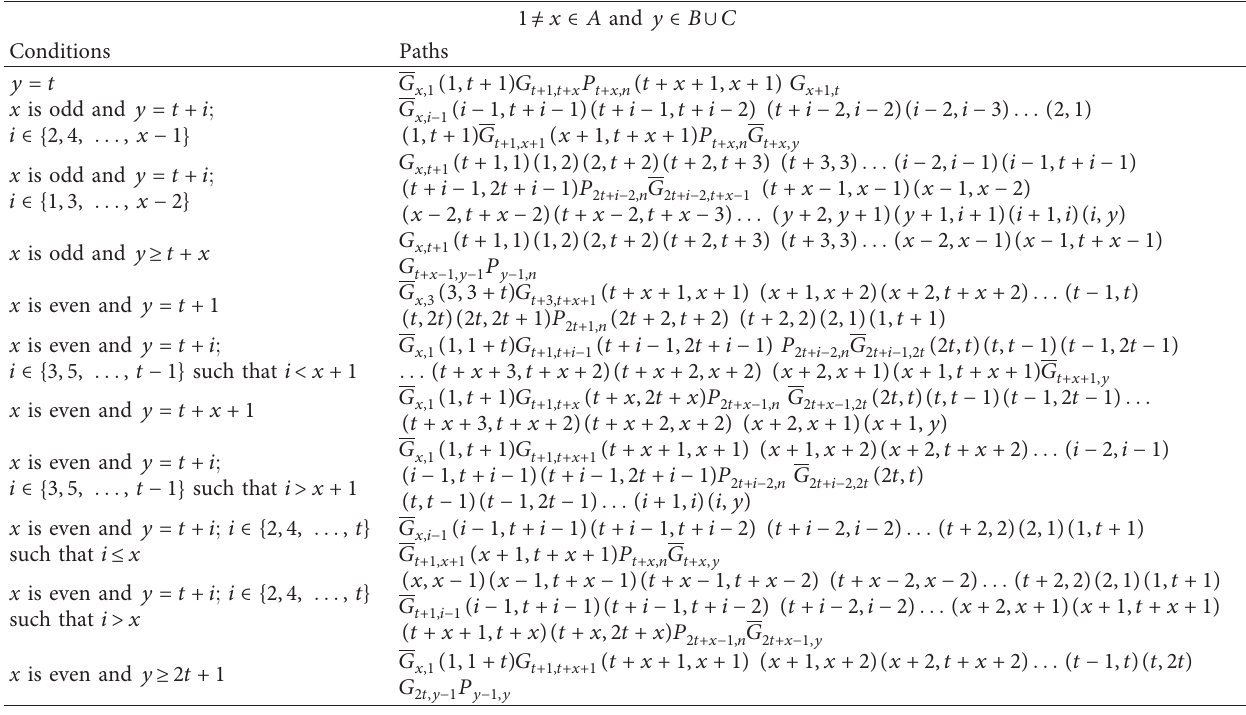
Table 3: Hamiltonian paths from 1 ≠ x to y in T when t is even. 1 ≠ x ∈ A and y ∈ B ∪ C